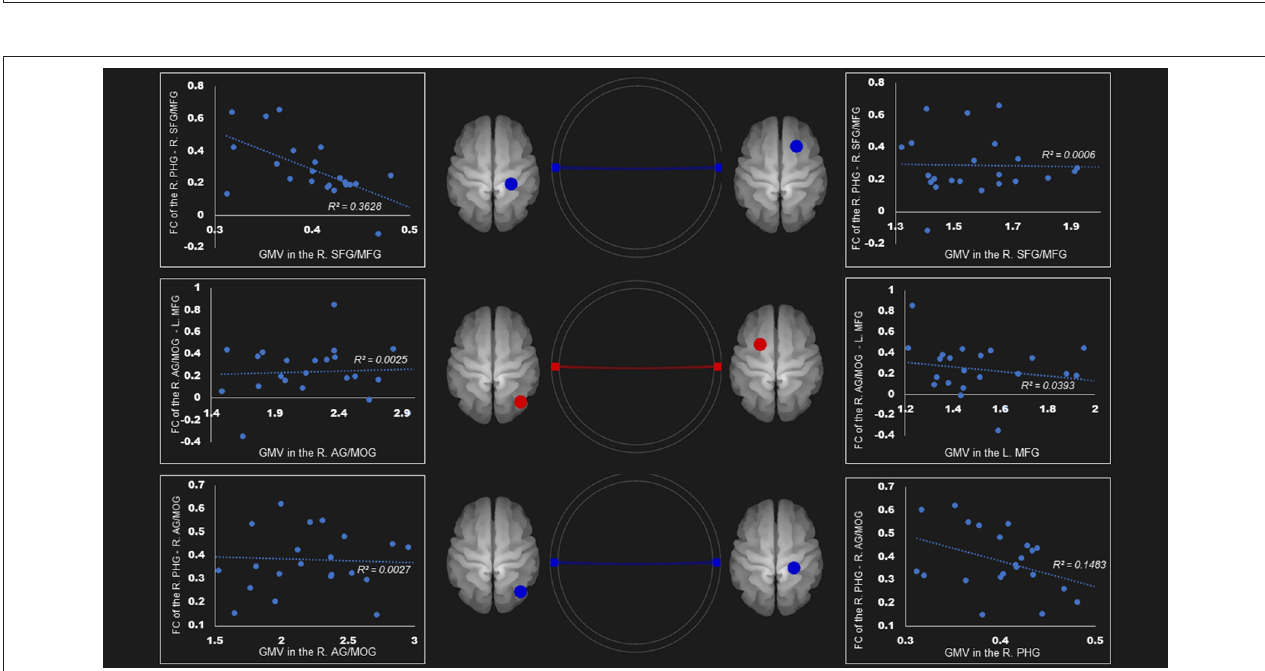
FIGURE 3 | Correlation between FC and gray matter volume in the ventral default mode network in the AUD group. Gray matter volume of right parahippocampal gyrus was negatively associated with the FC of the (1) right parahippocampal gyrus—right superior frontal gyrus/middle frontal gyrus ( r = − 0.60); (2) right parahippocampal gyrus—right angular gyrus/middle occipital gyrus ( r = − 0.39). Red and blue lines represent the positive and negative FC between ROIs, respectively. FC, functional connection; AG, angular gyrus; AUD, alcohol use disorder group; L, left; MFG, middle frontal gyrus; MOG, middle occipital gyrus; PHG, parahippocampal gyrus; R, right; SFG, superior frontal gyrus.